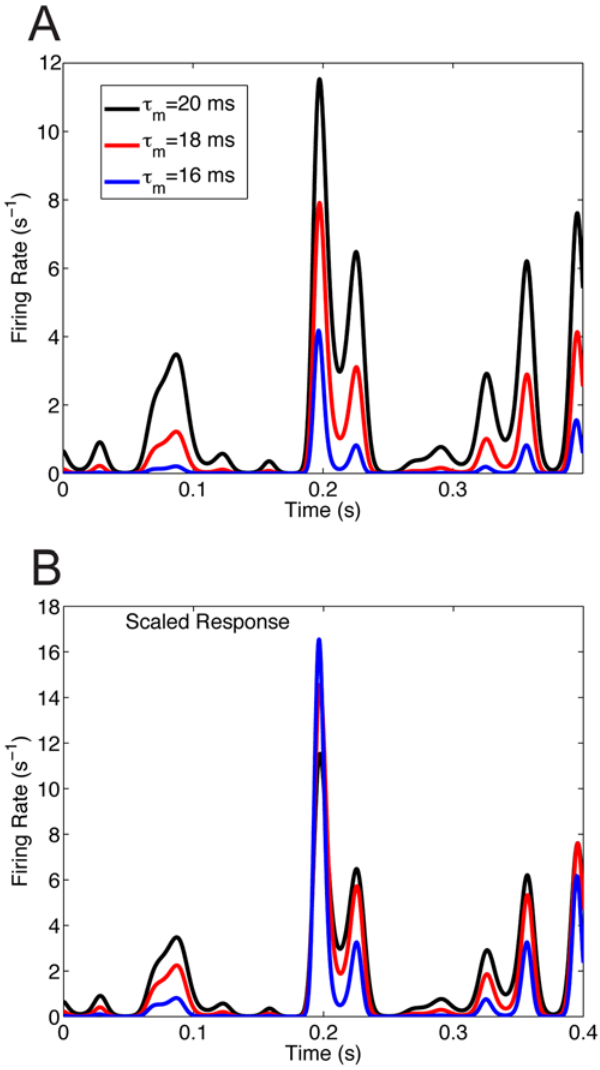
Figure 4. Background fluctuations required for divisive gain modulation. (A) The response with the same driver input as before (Fig. 3A), but with increased leakage conductance g l to mimic various background synaptic activity (conductance) levels in a deterministic way. The balanced background fluctuations levels ( n 0 (low) in all 3 curves. The black curve has t m ~ 20 ms (same curve in Fig. 3), the red curve has t m ~ 18 ms , and the blue curve has t m ~ 16 ms . (B) The three responses do not scale in a simple manner. A least squares fit c j (Equation (14)) was used.